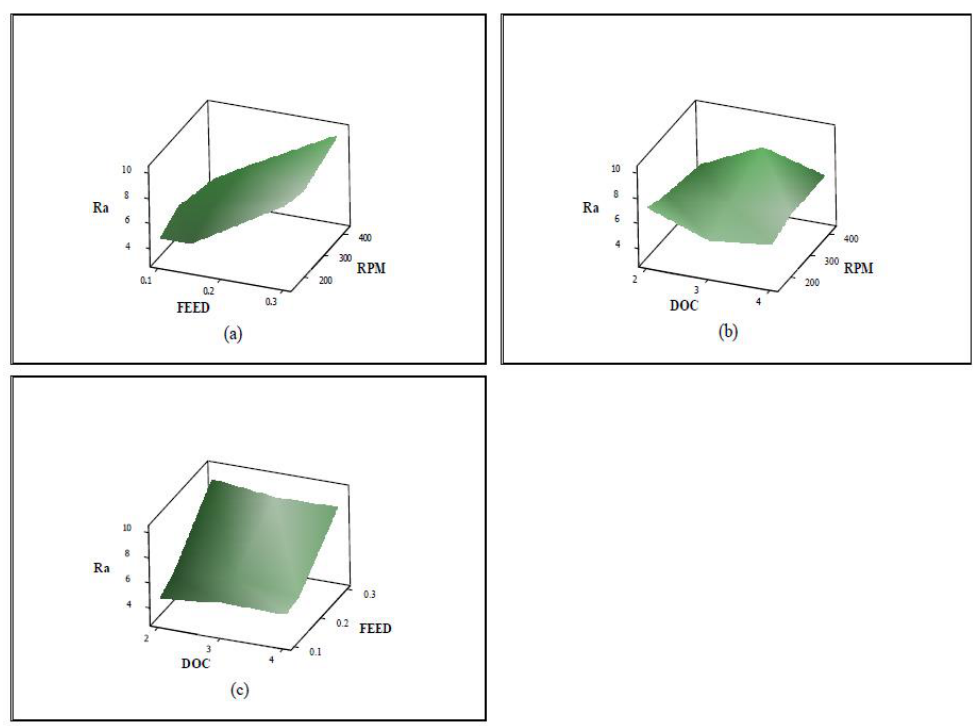
Figure 8. Surface plot of R a ( a ) R a Vs. f , N ( b ) R a Vs. d , N ( c ) R a Vs. d , f .